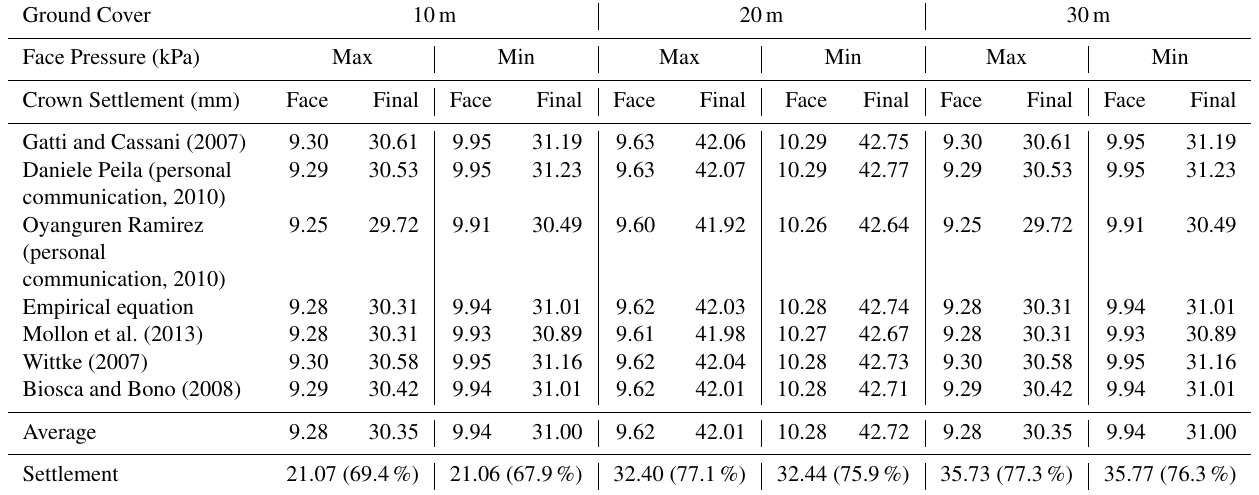
Table 4. Crown settlement according to face and backfill pressure (Case 5). Ground Cover Face Pressure